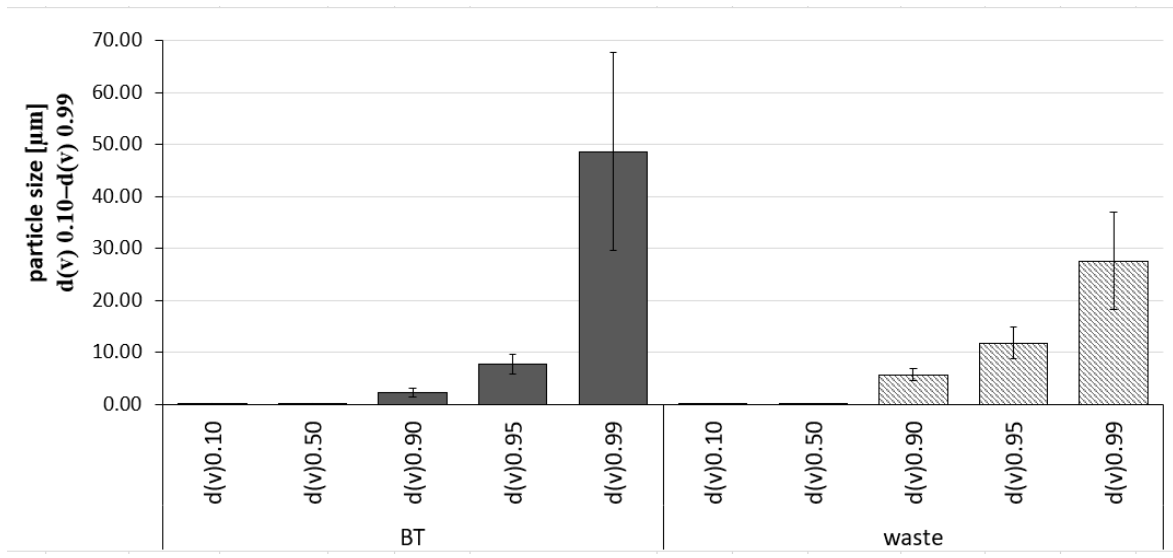
Figure 8. Laser diffraction data showing particle size of the PlantCrystals obtained from black tea (BT) leaves and their waste.